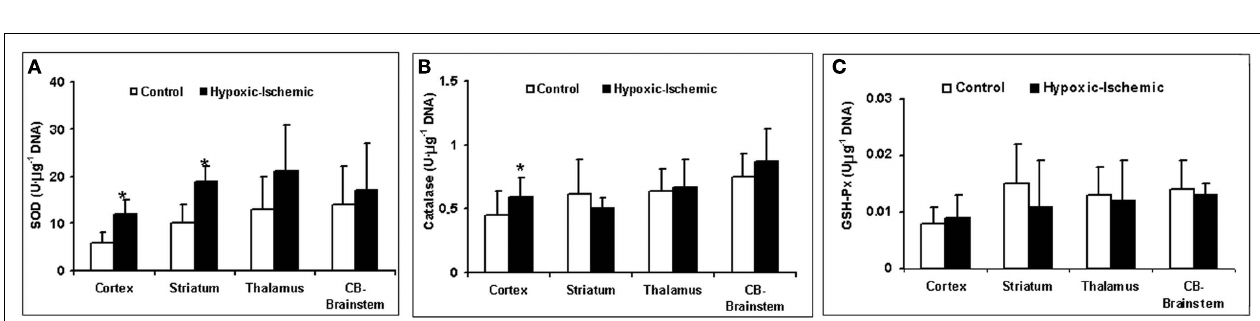
FIGURE 4 |Antioxidant enzymes activity (U μ g − 1 of DNA). (A) SOD activity. (B) Catalase activity. (C) GSH-Px activity as function of different brain regions and experimental group. * p < 0.05 vs. control group (one-factor